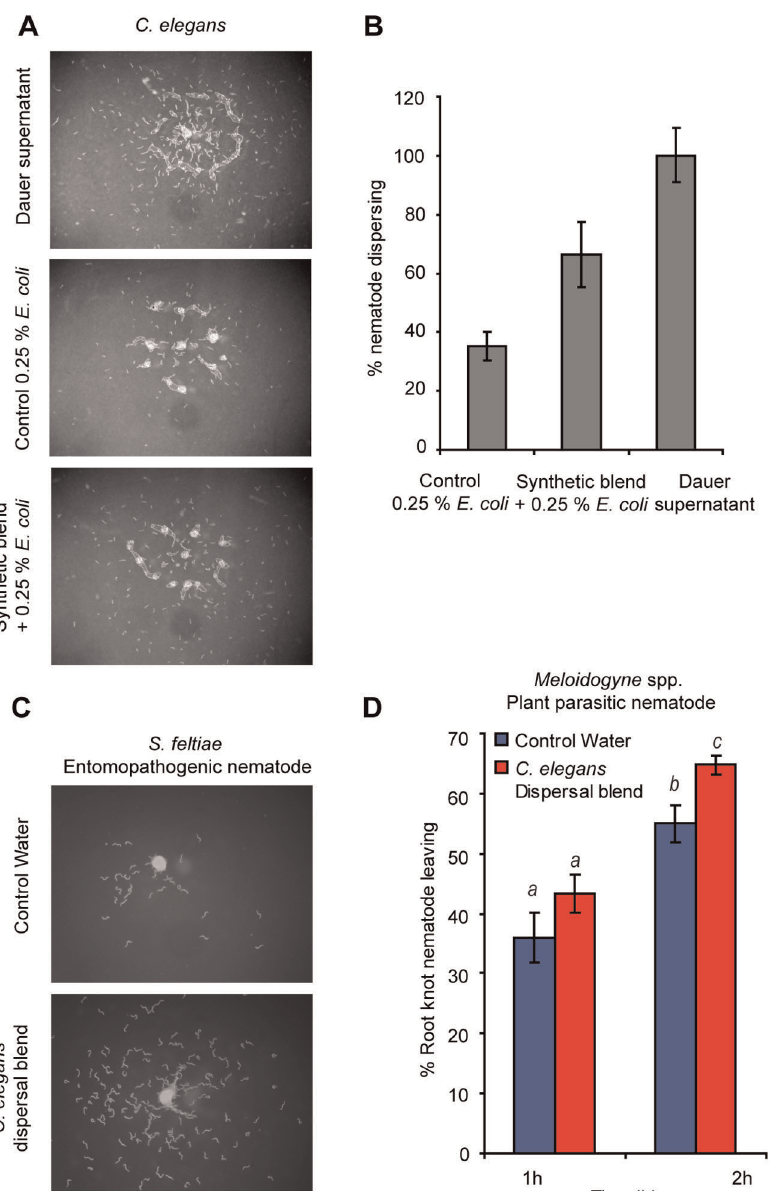
synthetic blend with 0.25% E. coli (HB101) and dauer supernatant, respectively. (B) Quantification using Image J (http://rsbweb.nih.gov/ij/download. html). Control vs synthetic blend student’s t-test unpaired (p , 0.02). (C) S. feltiae IJs ( , 250) response to the dispersal blend; four experiments for each treatment. (D) Response of root-knot J2s ( Meloidogyne spp., mixture of M. incognita , M. javanica , and M. floridensis ) to the C. elegans dispersal blend. The data represent 19 and 20 experiments from control water and C. elegans dispersal blend, respectively. At 2 h, using a student’s t-test,